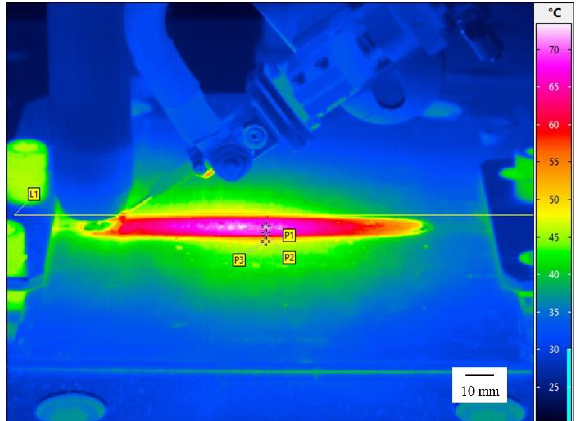
Figure 7. The captured image from a high-speed infrared thermography camera. Metals 2020 , 10 , x FOR PEER REVIEW Figure 8. The temperature profile of run order 1.